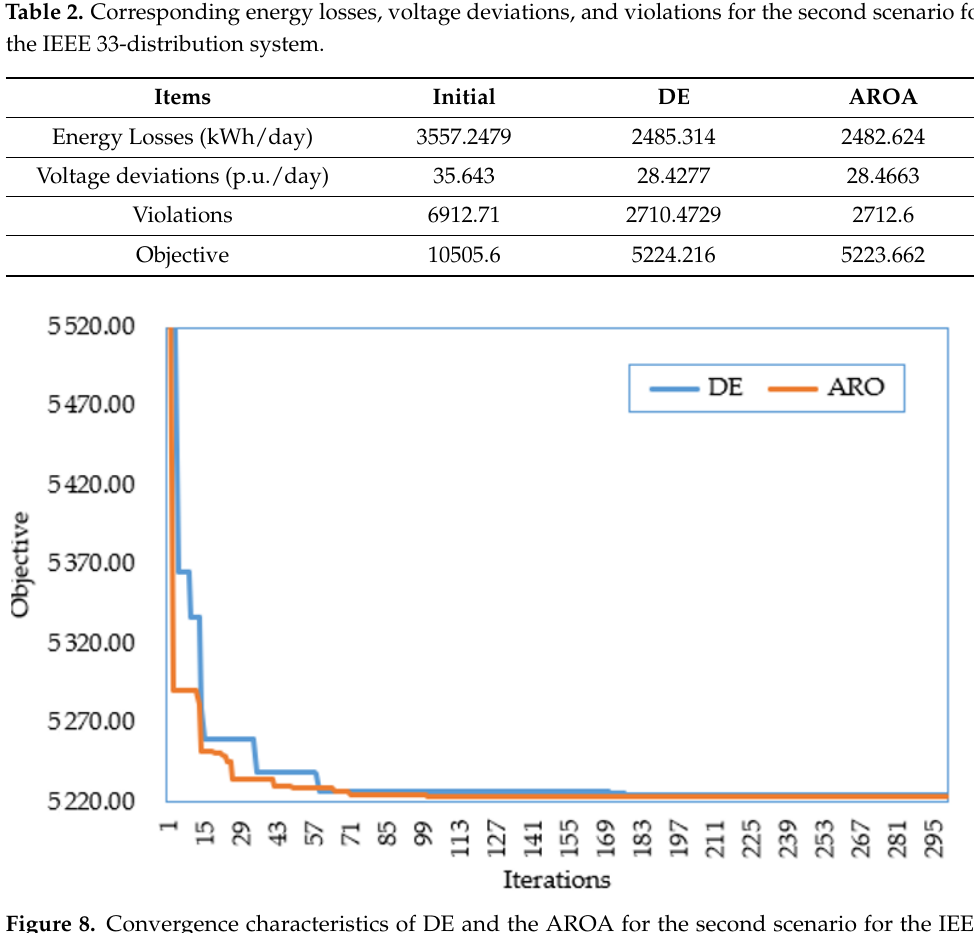
Table 2. Corresponding energy losses, voltage deviations, and violations for the second scenario for the IEEE 33-distribution system .